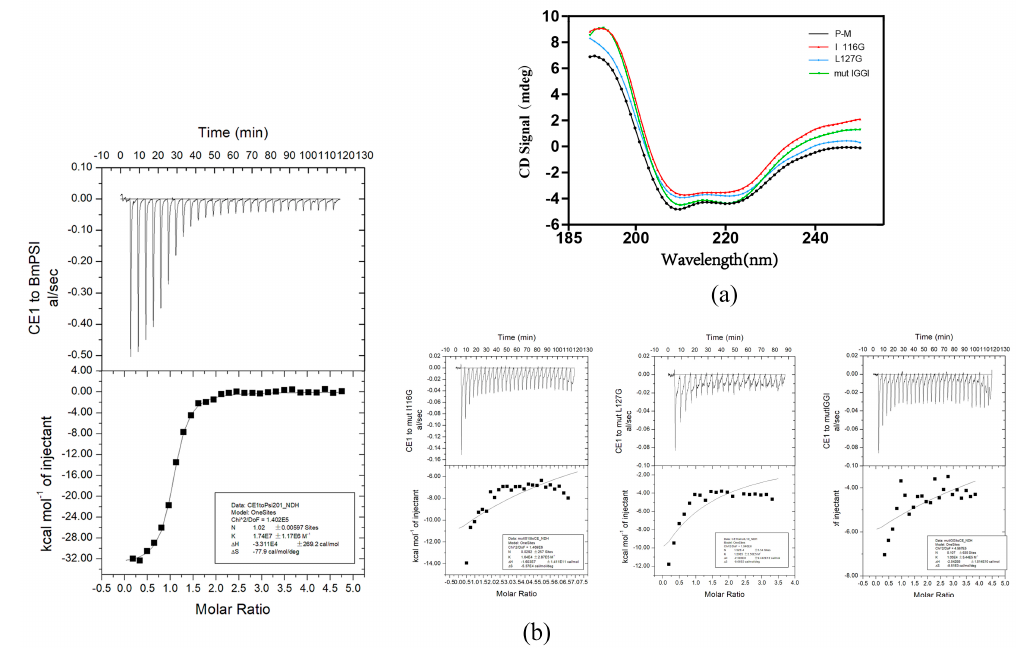
Figure 3. Two amino acids in the KH_1-1 motif of BmPSI play important roles in the binding with CE1: ( a ) The secondary structures of wild-type BmPSI and three kind of amino acid mutant proteins detected with circular dichroism (CD) spectroscopy. ( b ) The RNA binding affinity of three kinds of amino acid mutant proteins and wild-type BmPSI were assessed, showing different exports of isothermal titration calorimetry (ITC) under the same conditions. Table 1. The energetic profile of the interaction of the BmPSI with CE1 obtained from ITC Molecule